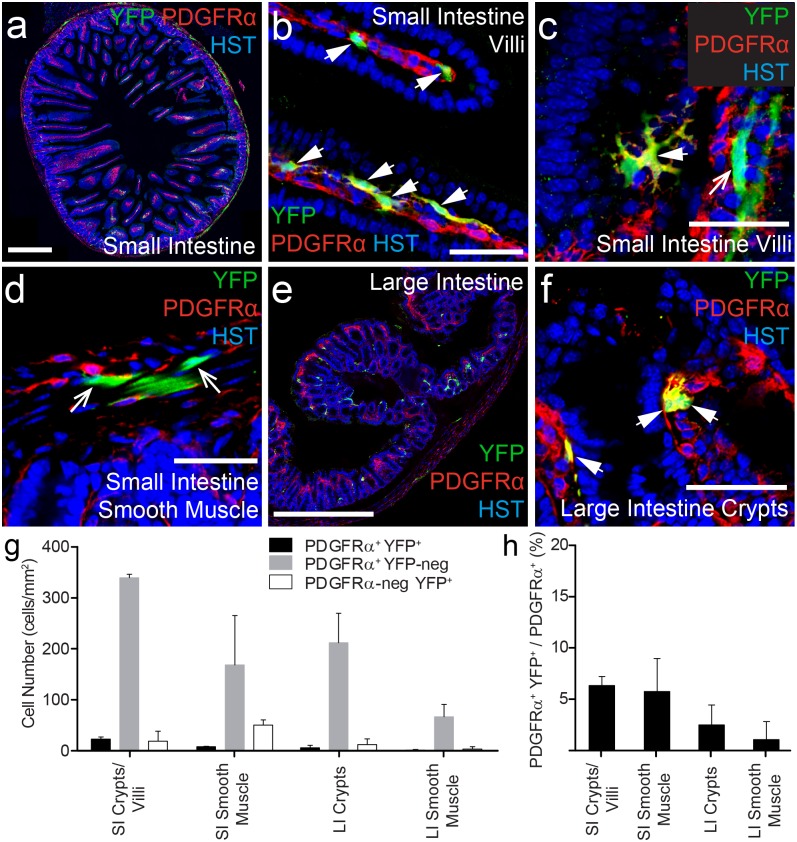
A small proportion of PDGFRα+ cells become YFP-labelled in the intestine.Cryosections from P57+7 Pdgfrα-CreERT2::Rosa26-YFP transgenic mice were immunostained to detect PDGFRα (red), YFP (green) and HST (blue). Confocal images (single z plane) of the small intestine at low (a) and high (b-d) magnification. Confocal images (single z plane) of the large intestine at low (e) and high (f) magnification. (g) The number of PDGFRα+ YFP+, PDGFRα+ YFP-negative and PDGFRα-negative YFP+ cells quantified from confocal images (single z plane) of the small (SI) and large (LI) intestine expressed as the number of cells per mm2. (h) The proportion of PDGFRα+ cells that become YFP-labelled (PDGFRα+ YFP+ cells / total PDGFRα+ cells, expressed as a percentage) quantified from confocal images (single z plane) of the small and large intestine. Error bars represent mean ± std dev from n = 3 mice. PDGFRα+ YFP+ cells are denoted by arrowheads. PDGFRα-negative YFP+ cells are denoted by arrows. Scale bars in (a) and (e) represent 500μm, All other scale bars represent 50μm.